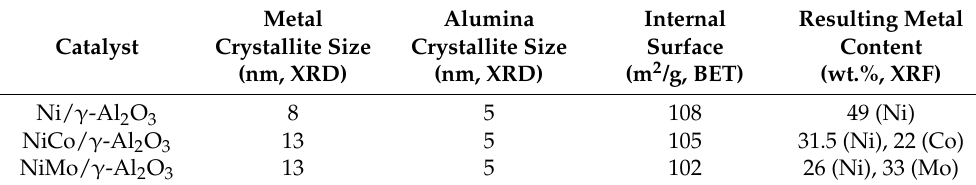
Table 2. Basic properties of used catalysts.